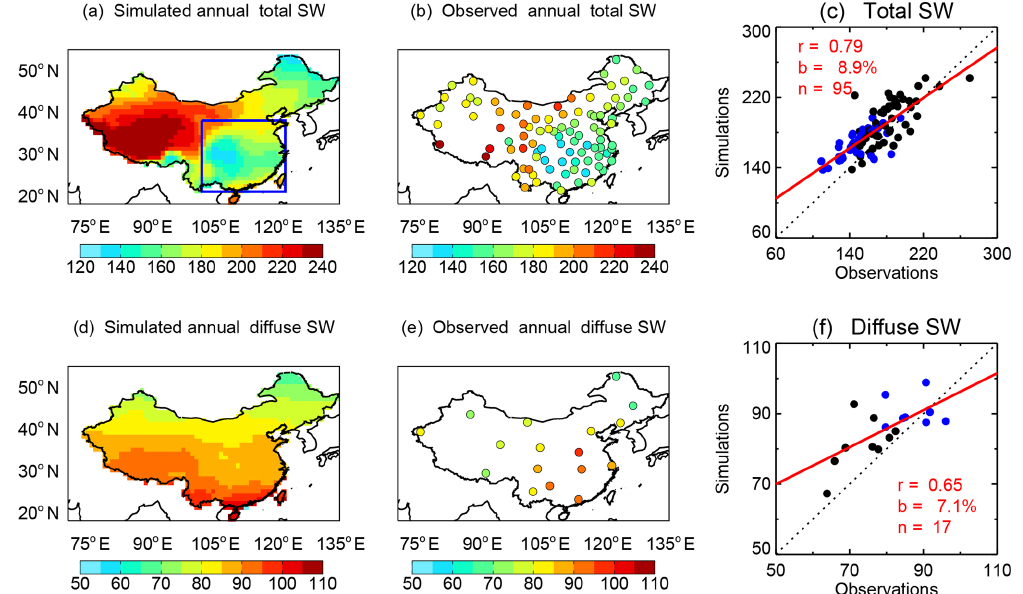
Figure 2. Evaluation of radiation fluxes with site-level observations. Simulations are surface (a) total shortwave radiation (Wm − 2 ) and (d) diffuse radiation derived with method M01 (Table S4) for the period of 2005–2015 from an ensemble of seven CMIP5 climate models. Observations (b, e) are the average during 2009–2011 from 106 sites operated by the Climate Data Center, Chinese Meteorological Admin- istration. The correlation coefficients ( r ), relative biases ( b ), and number of sites ( n , excluding sites lacking data) are shown in the scatter plots (c, f) . The blue points in the scatter plots represent sites located within the box regions in eastern China as shown in (a) . The dashed line represents the 1 : 1 ratio. The red line is the linear regression between simulations and